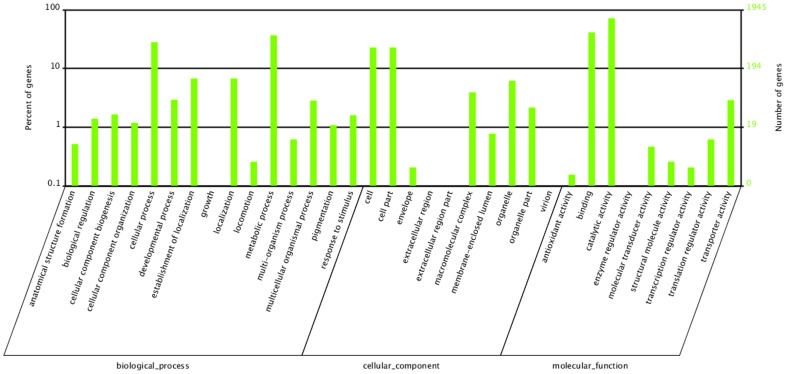
Classification of the gene ontology (GO) for the transcriptome of P.splendens.The results are summarized in three main categories: biological process, cellular component and molecular function. The right y-axis indicates the number of genes in a category. The left y-axis indicates the percentage of a specific category of genes in that main category.